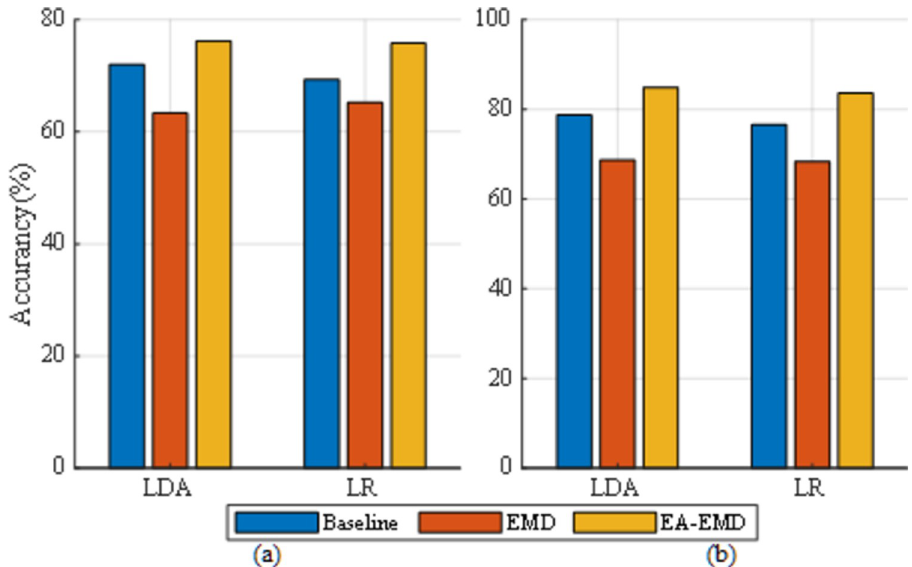
Fig 10. The classification accuracies achieved by training the two classifiers (LDA and LR) with 20 artificial trials (yielded by EMD and EA-EMD) and with 20 real EEG trials (Baseline) for (a) data set 1 and (b) data set 2.